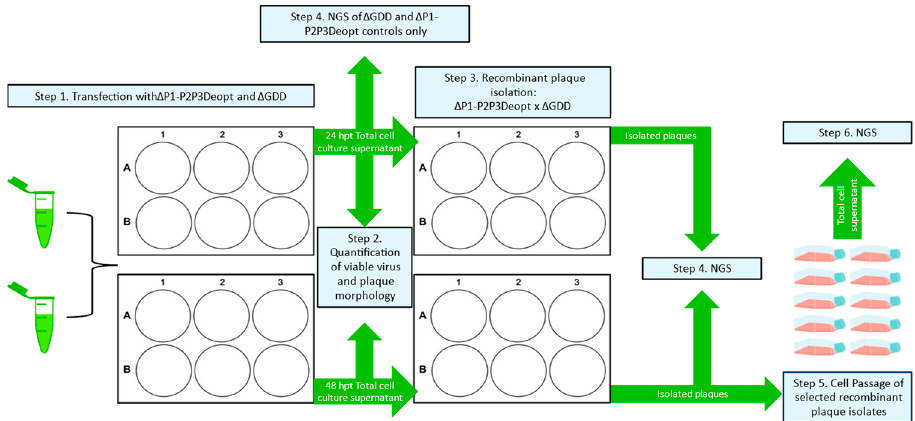
Figure 3. Experimental design schematic of the Δ P1-P2P3Deopt × Δ GDD recombination assay and the proceeding viral quantification, plaque isolation, plaque passing, and sample types that were sequenced by NGS.